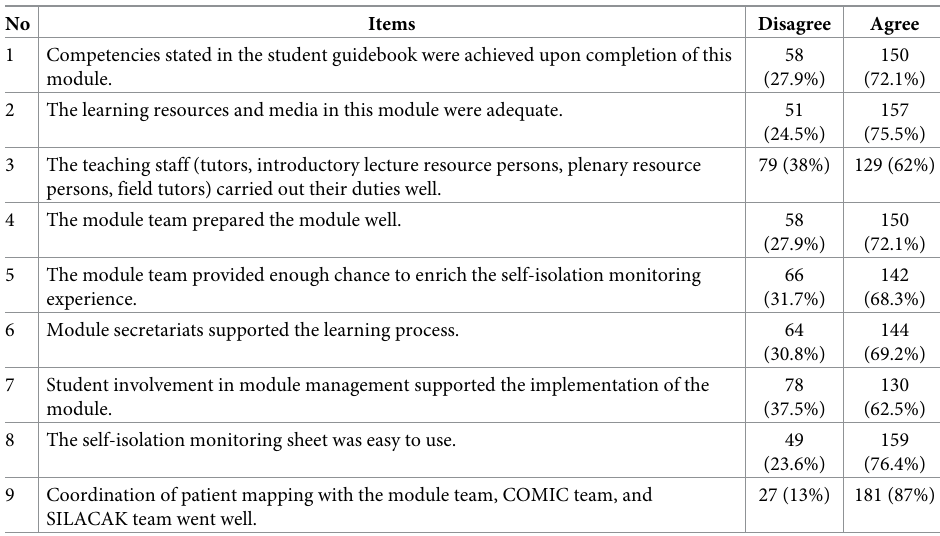
Coordination of patient mapping with the module team, COMIC team, and SILACAK team went well.